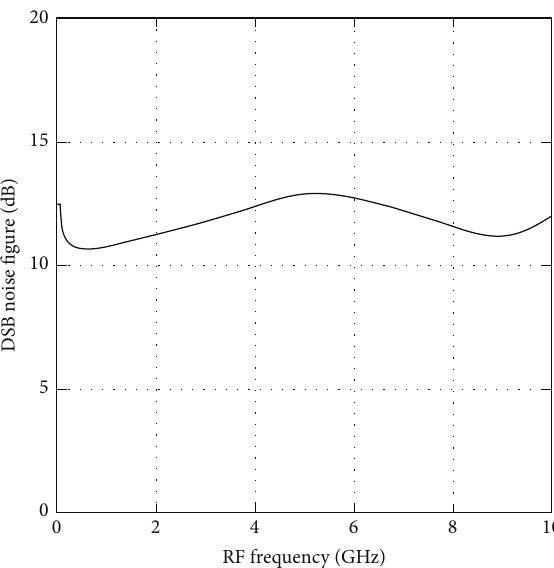
Figure 7: Simulated CG versus RF frequency.